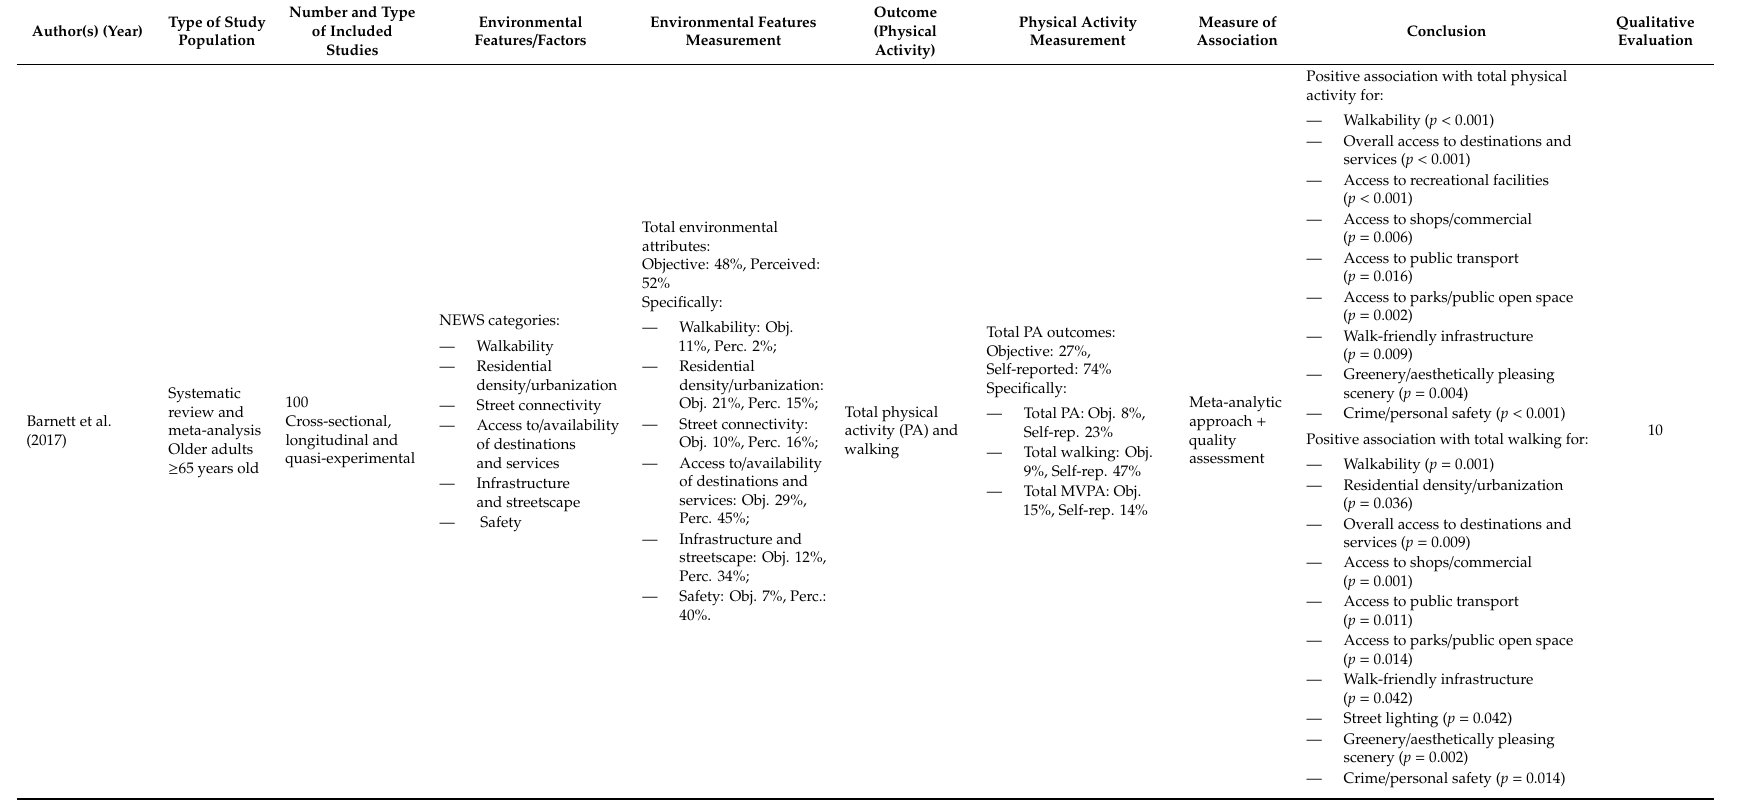
Table 2. Main elements of the included